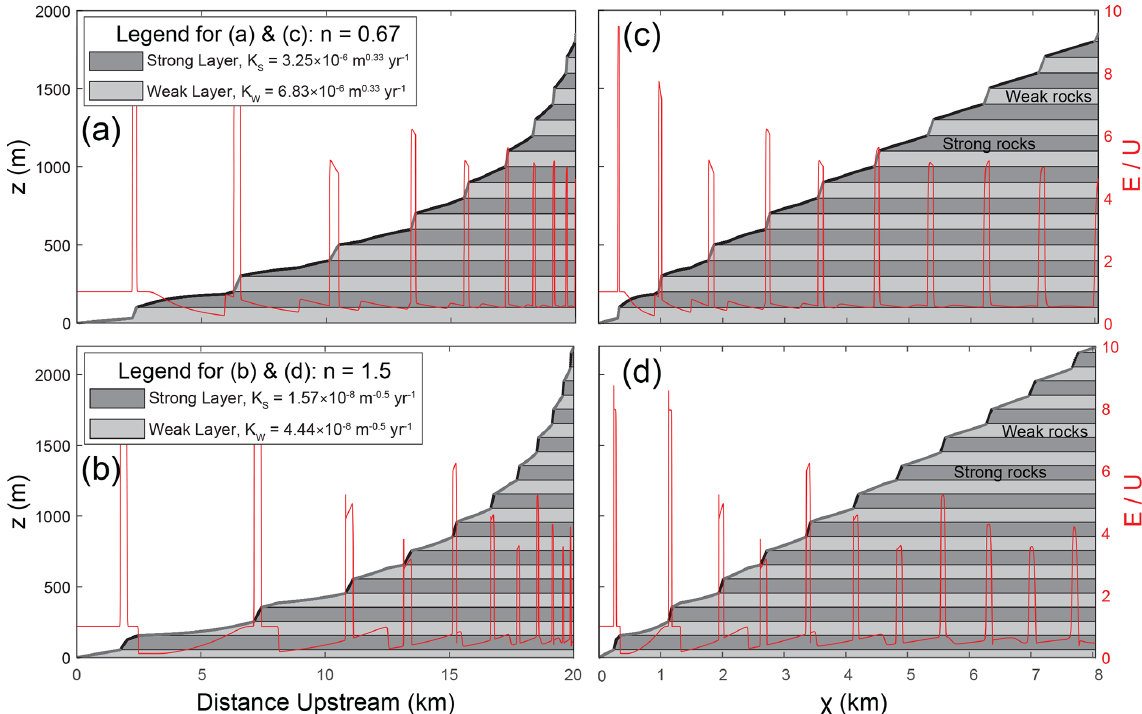
Figure 3. Longitudinal profiles (a, b) and χ plots (c, d) for two different simulations. The simulation in (a) and (c) has slope exponent n values of 0.67, while the simulation in (b) and (d) has n = 1 . 5. Layer thickness H and rock-uplift rate U are 100m and 0.15mmyr − 1 in both simulations,